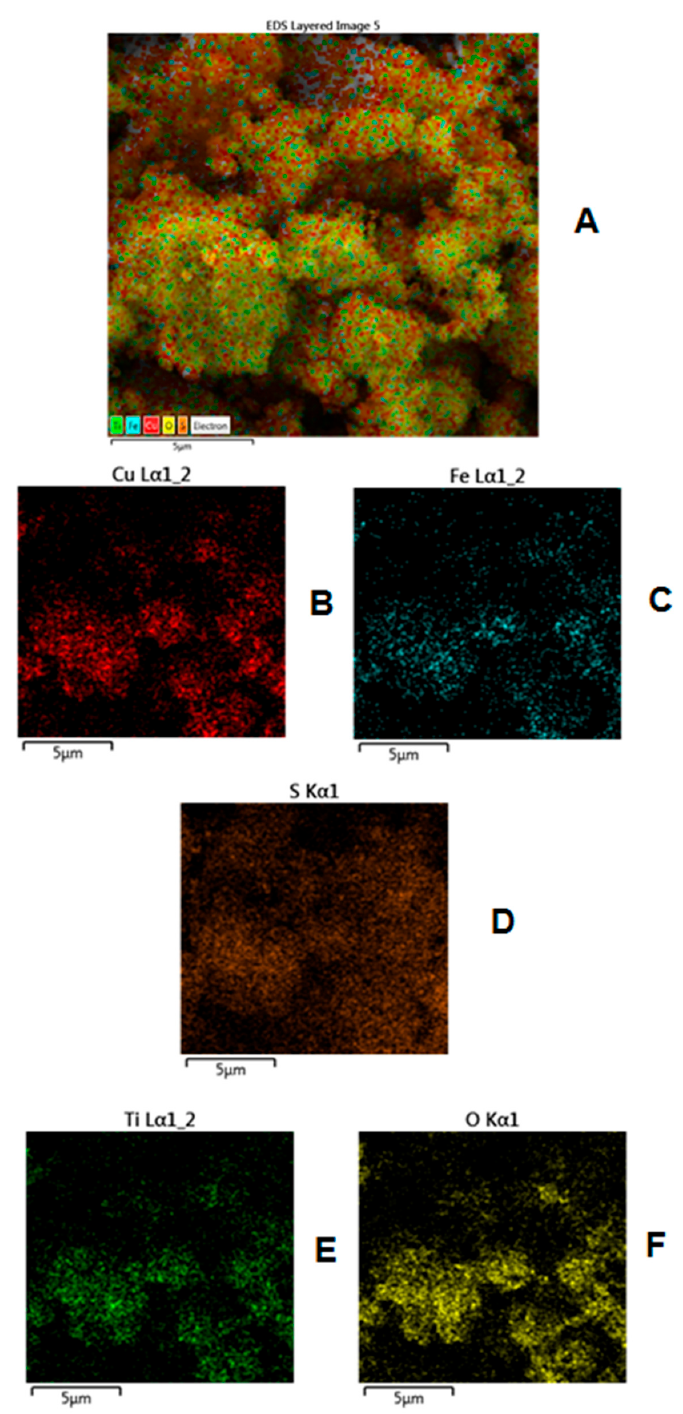
Figure 5. EDS mapping of CuFeS 2 /TiO 2 nanocomposite. ( A ) EDS layered image; ( B ) elemental mapping for Cu distribution; ( C ) elemental mapping for Fe distribution; ( D ) elemental mapping for S distribution; ( E ) elemental mapping for Ti distribution; ( F ) elemental mapping for O distribution.